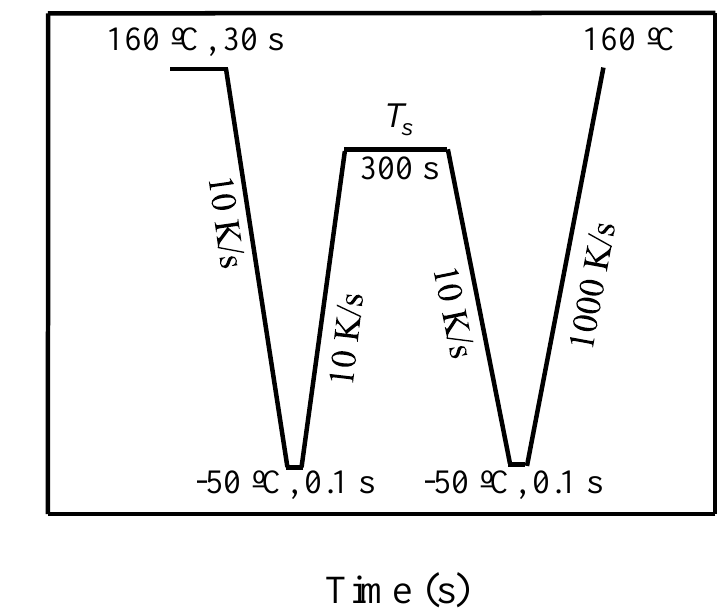
Figure 1. Standard self-nucleation procedure employed to investigate melt memory effects.